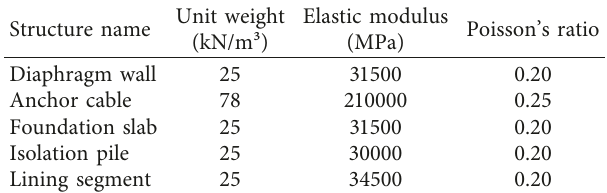
Table 6: Physical and mechanical parameters of the structure.